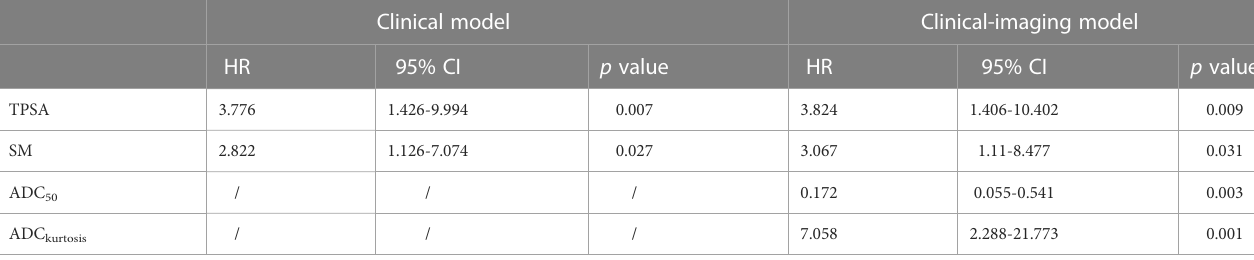
TABLE 3 Prognostic model analysis with and without histogram parameters for BCR-fs. Clinical